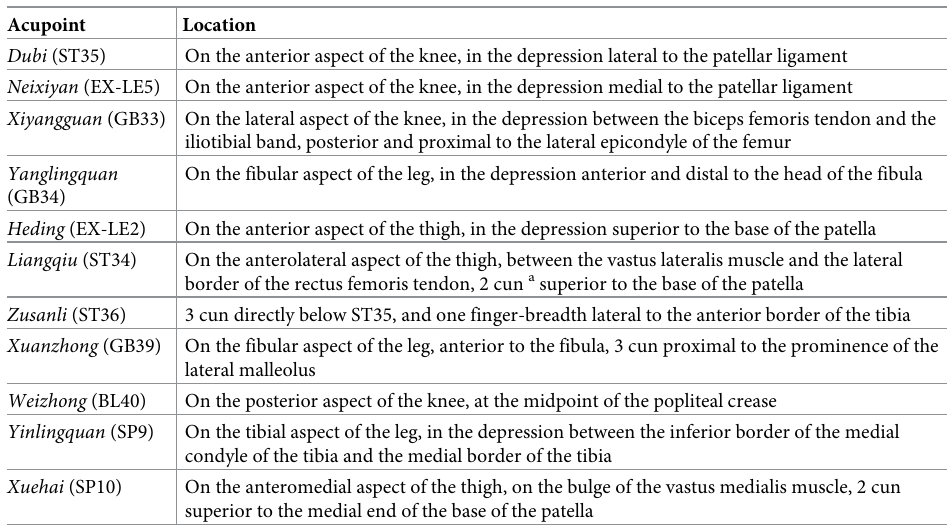
Table 1. Positioning of